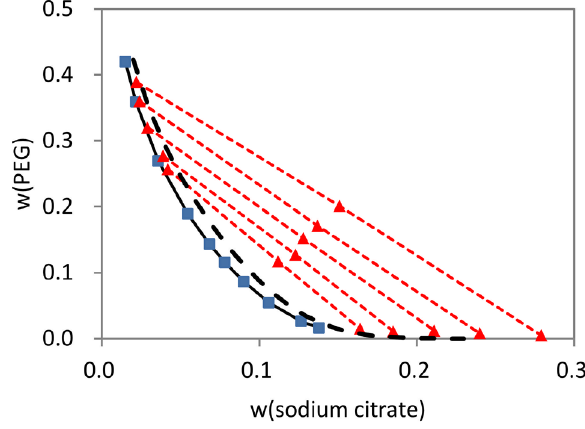
Figure 1: Binodal curve (■) and tie-line ( ▲ ) of PEG 10000 + sodium citrate + H O at T = 298.15 K and P = 84 kPa. Dash line is the cloud 2 point data in [15] (PEG 8000 + sodium citrate + H comparison.